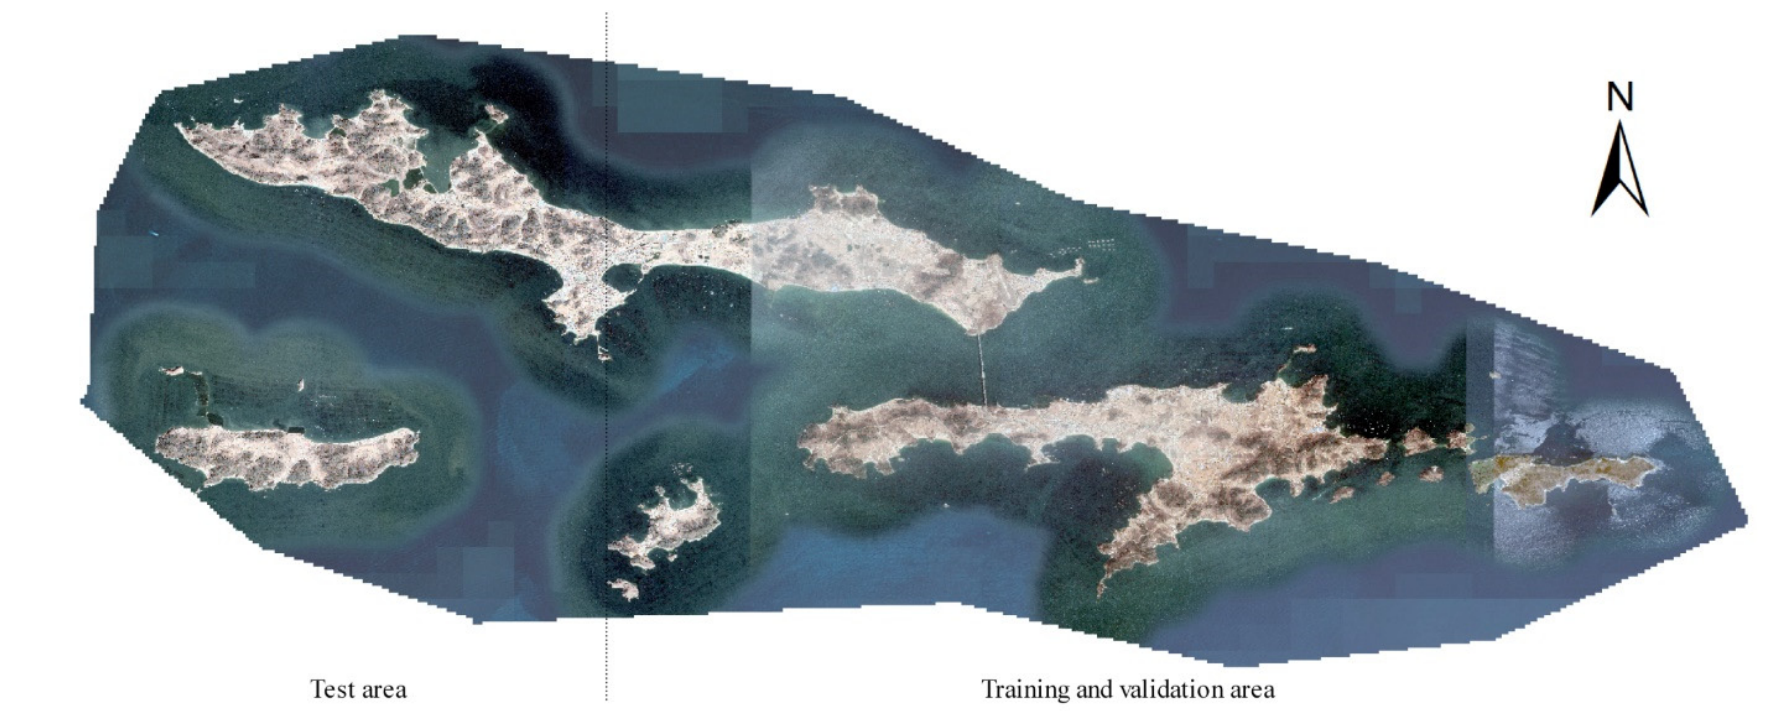
Figure 6. The study region of Dachangshan Island of China with a RGB image.